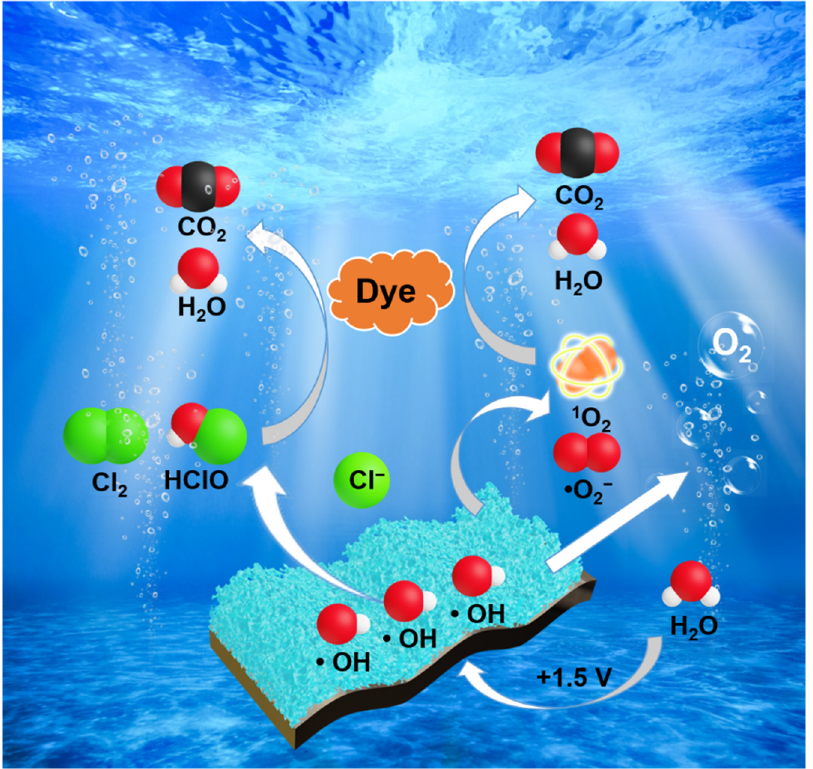
Figure 7. Schematic illustration of the electrocatalytic degradation of dye molecules by np-Ni@NiO-4 electrode.